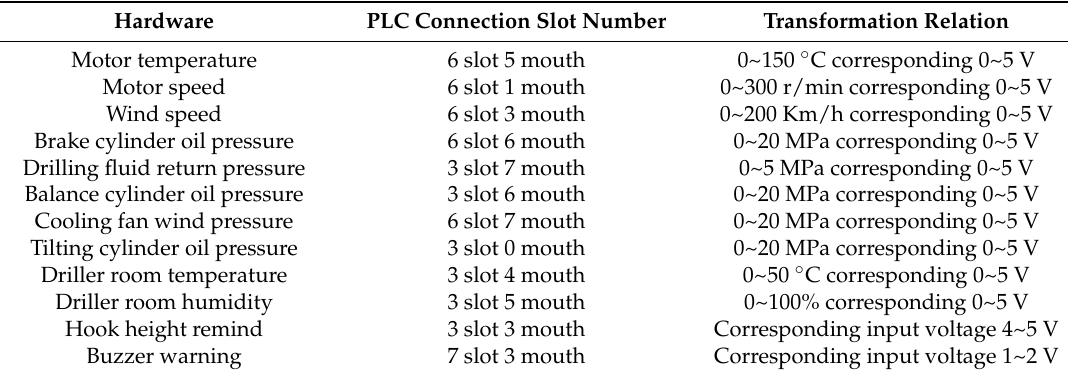
Table 4. PLC module connection slot number and the convert